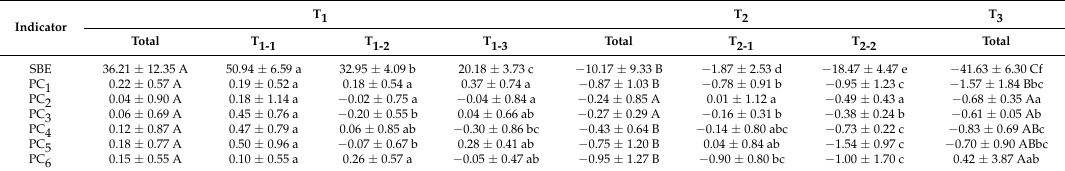
Table 5. Differences of SBE values and color factors in six